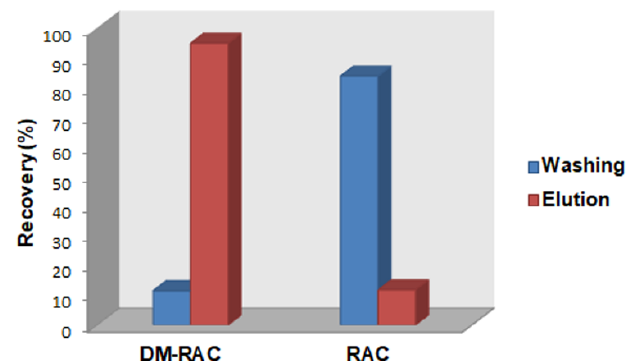
Figure 8. Recovery yield in washing and elution steps for DM-RAC (10 µg mL −1 ) and RAC (10 µg mL −1 ) loaded on DM-RAC-MISPE cartridge packed with